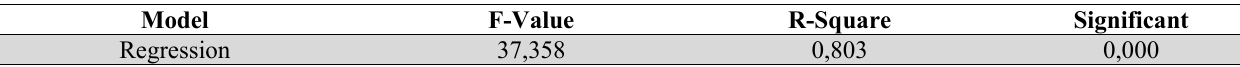
F-table = K: n-k = 3: 128- = 3: 125 =